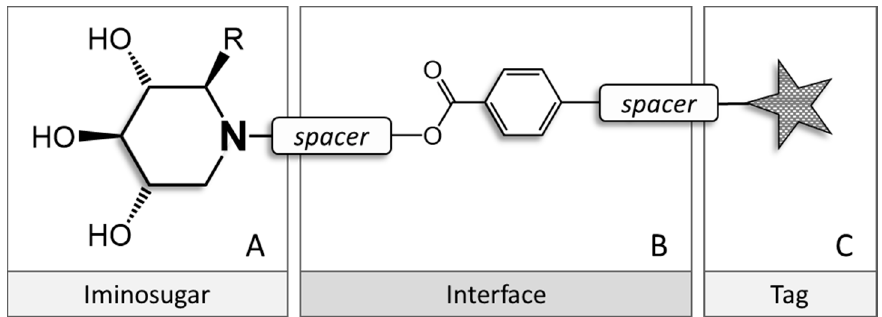
Figure 4. Building block concept for iminosugar-based ligands (R = CH 2 OH or